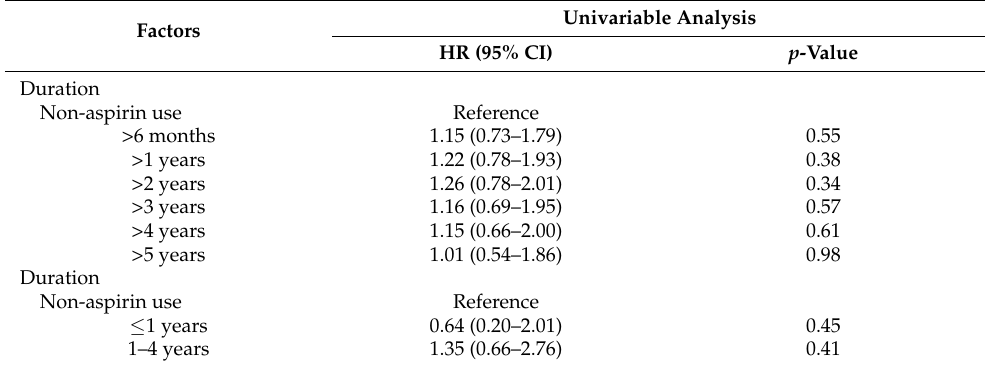
Table 3. Association between duration of use of aspirin and gastric